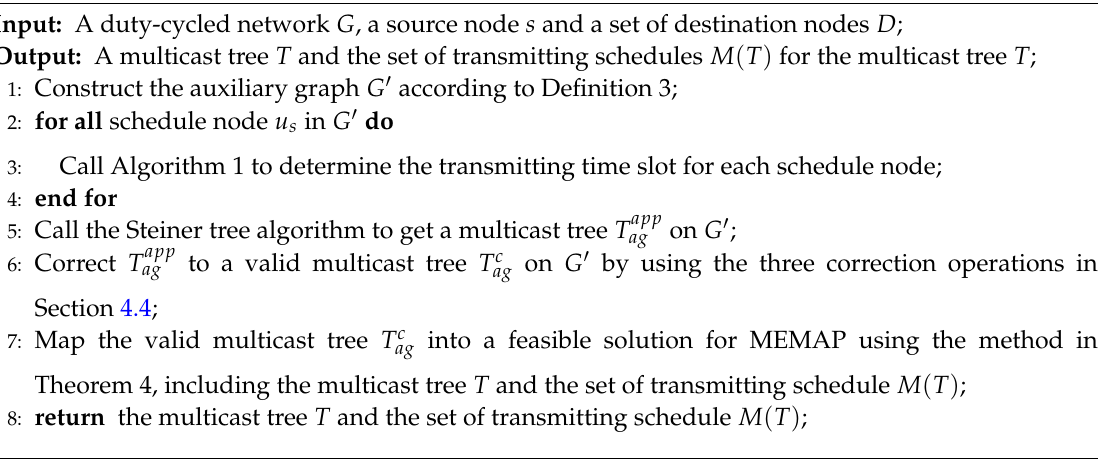
Algorithm 2 Approximate scheduling and constructing